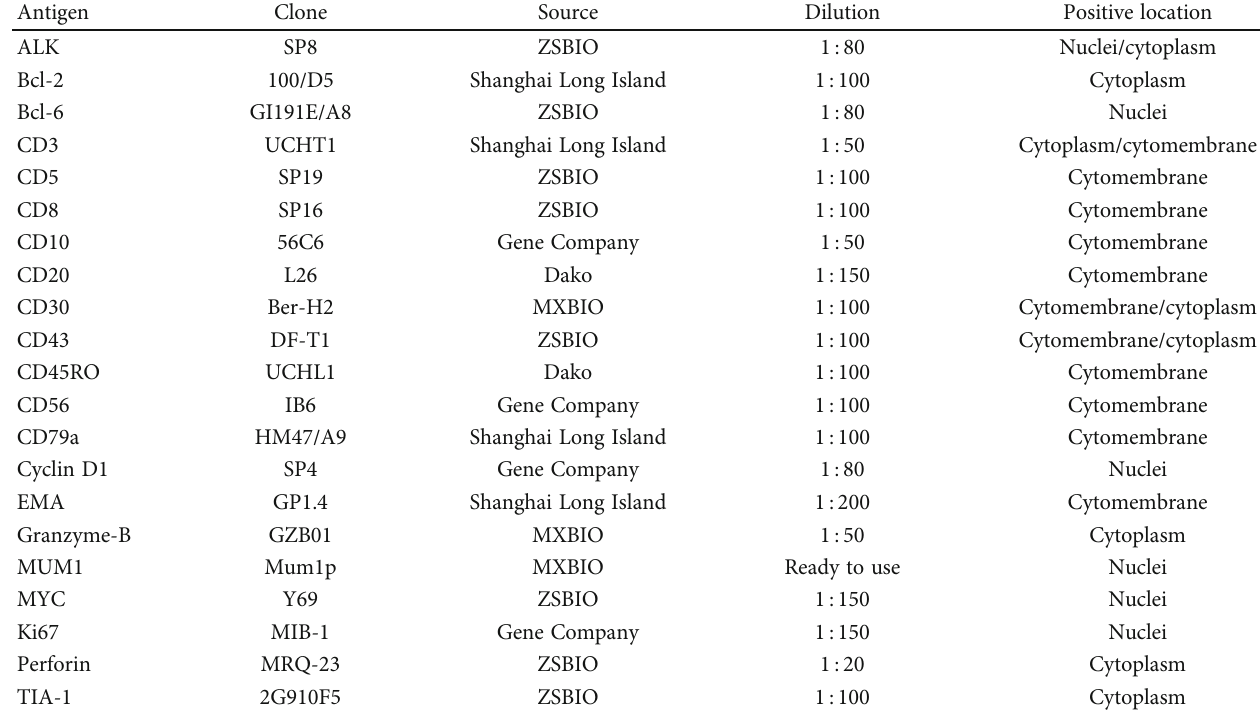
Table 1: Primary antibodies and conditions used for immunohistochemical